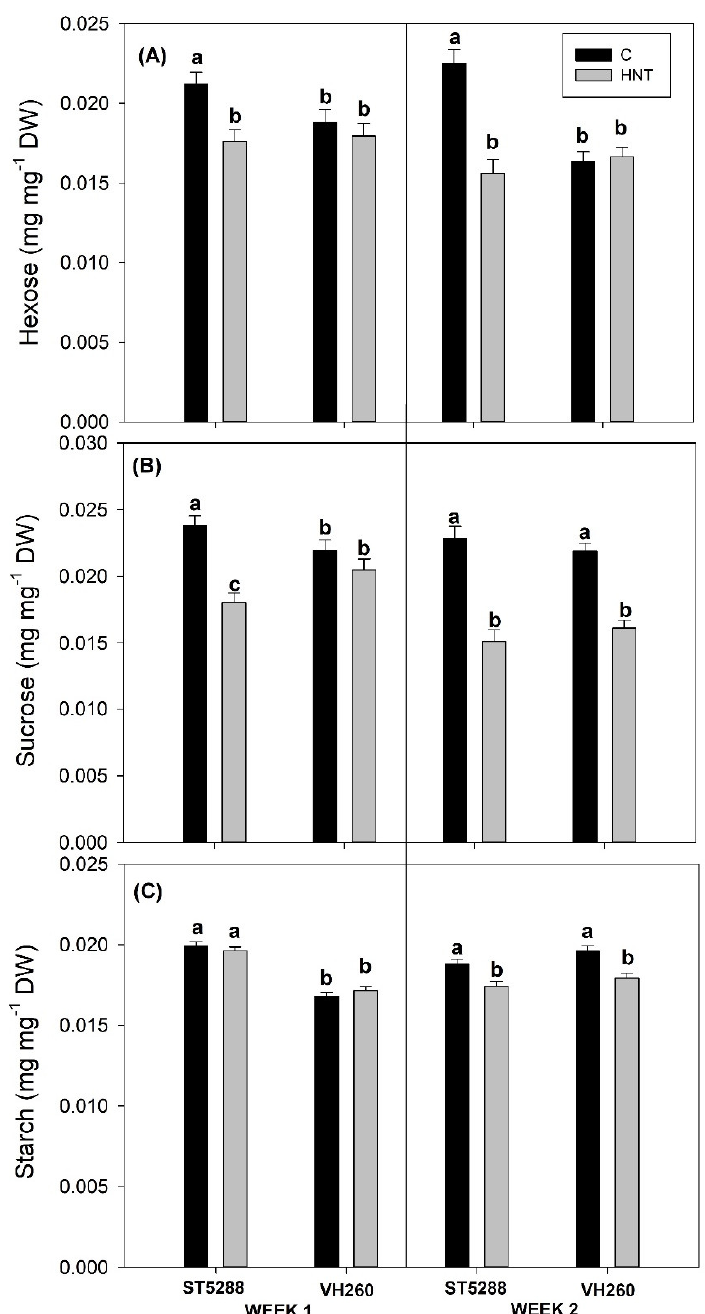
Figure 4. Effect of high night temperatures on subtending leaf hexose ( A ), sucrose ( B ), and starch ( C ) concentrations at the end of the first and second week after initiation of the treatment. Columns connected with different letters are significantly different ( p = 0.05). Error bars represent ±1 standard error. (C: control temperatures 32/24 °C, HNT: high night temperatures 32/30 °C).